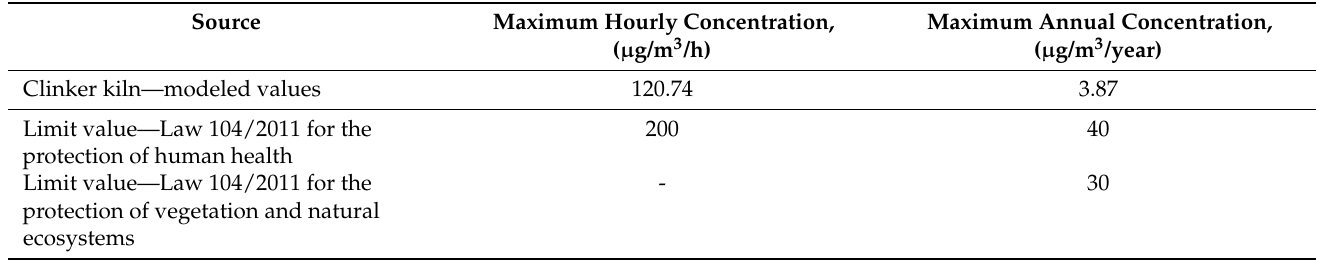
Table 9. Maximum NOx concentrations extracted from modeling (hourly and